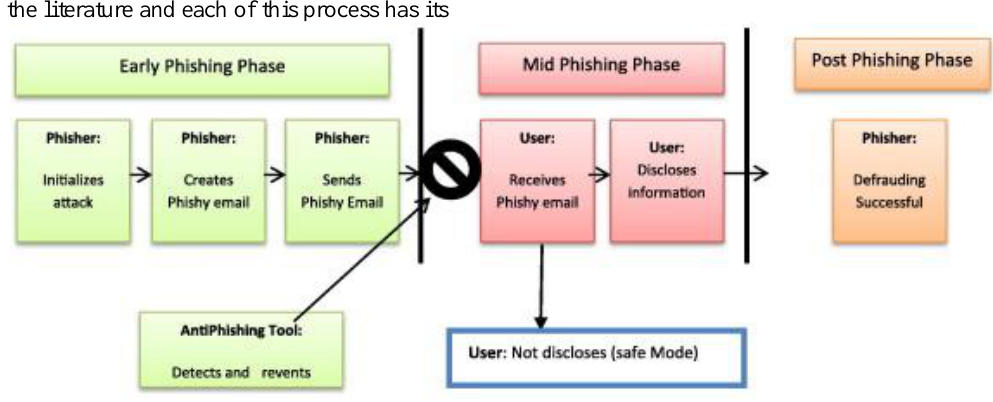
Figure. 3. Phishing life